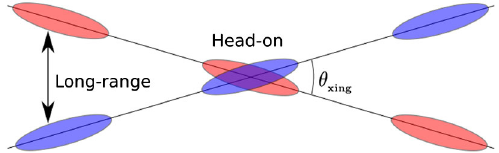
FIG. 1. Illustration of the crossing of beam 1 and beam 2 at the IPs in circular colliders (not to